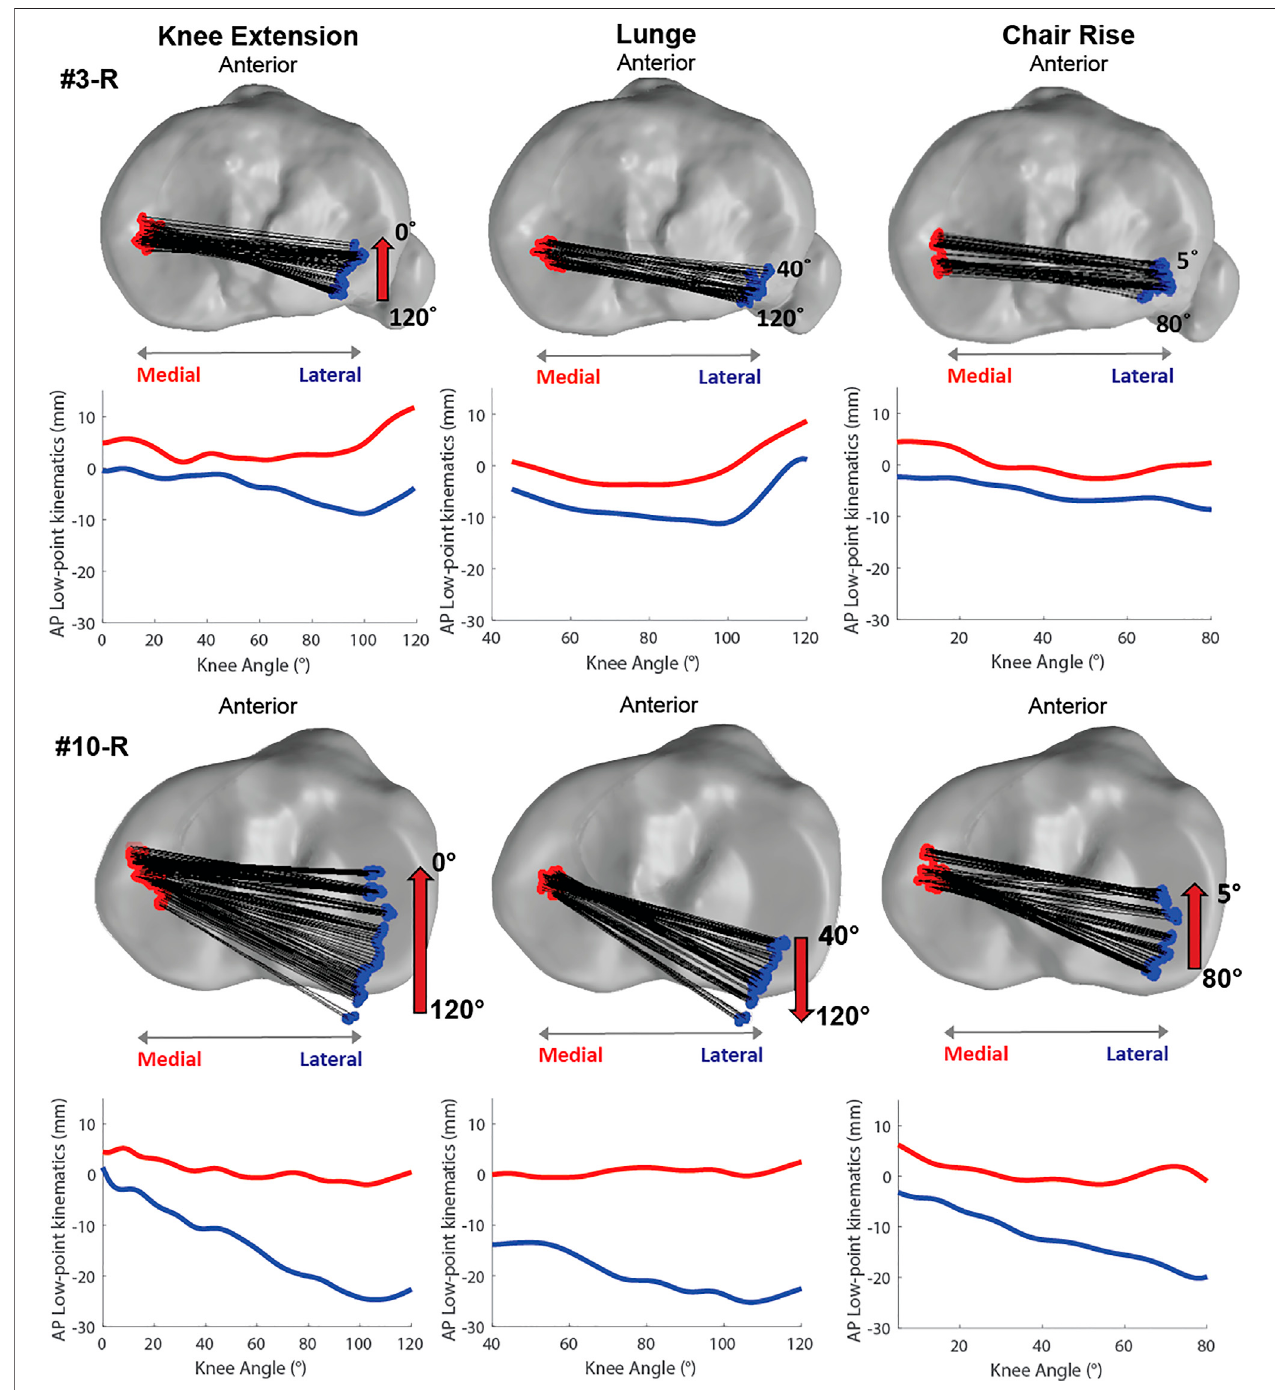
FIGURE 3 | Illustrative low-point kinematics for two subjects during the three activities showing consistent tibial rotation across activities with distinct subject differences.